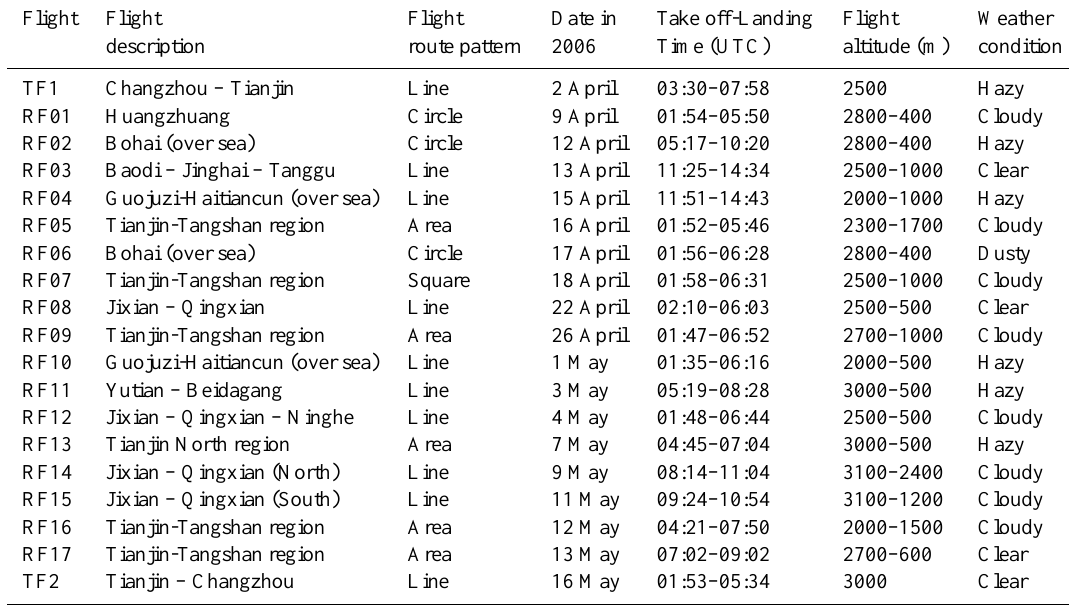
Table 2. Overview of aircraft flights performed during